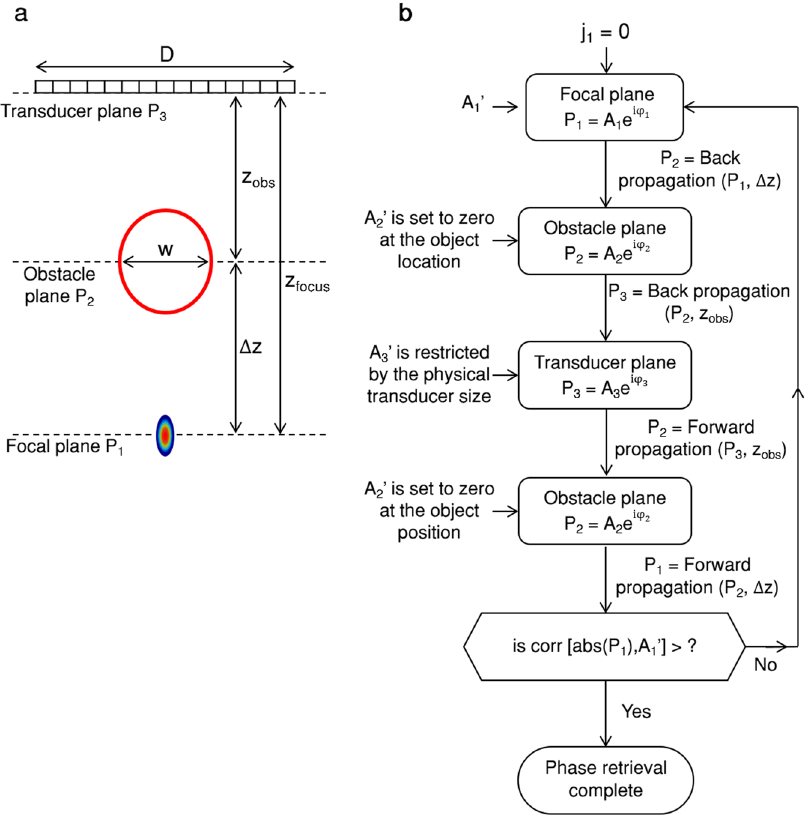
Figure 2. Pattern design illustration. ( a ) Schematic representing ultrasound imaging of an object behind an impenetrable obstacle. There are three planes of interest: the transducer plane, the obstacle plane, and the focal plane, which have acoustic fields of P 1 , P 2 and P 3 , respectively. An obstacle with a width w is located at a distance of z obs from the transducer. The goal is to generate a focal spot at the target location, which is positioned at a distance Δ z from the obstacle. ( b ) Flowchart of the modified Gerchberg–Saxton process designed to create a focal point behind an